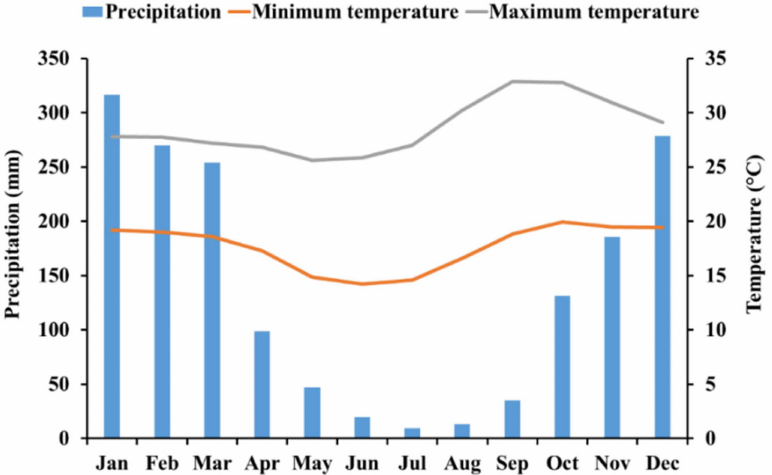
Figure 2. Average monthly precipitation and average minimum and maximum monthly temperature between 1979–2013 at the EPA of the Uberaba